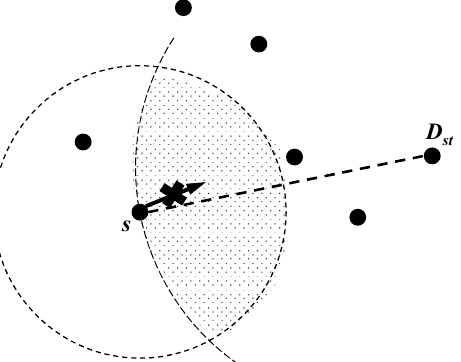
Figure 2. Greedy forwarding failure during the data